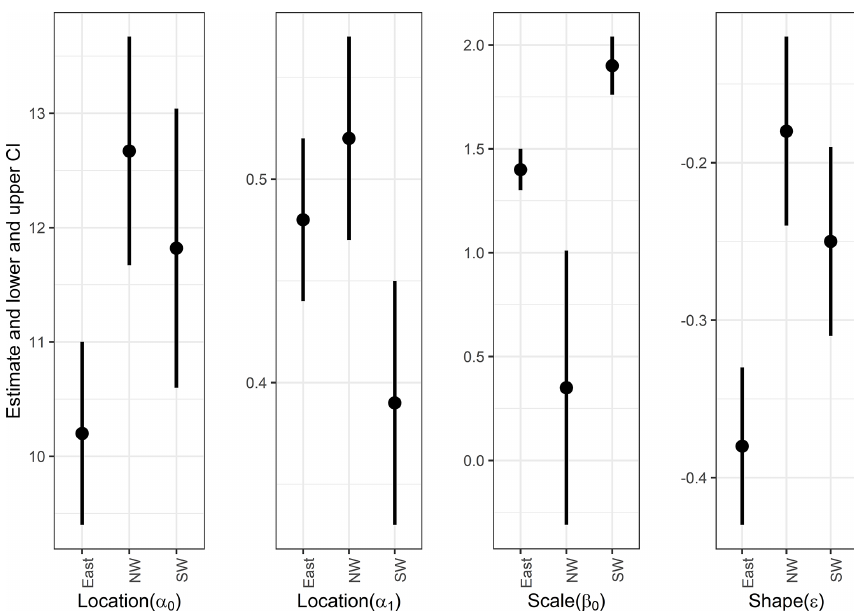
Figure 10. The 95% confidence intervals of estimated parameters based on the best GEV model fitted to the winter minimum temperature in three clusters using Irkutsk data. Numerical values are listed in Table S5.